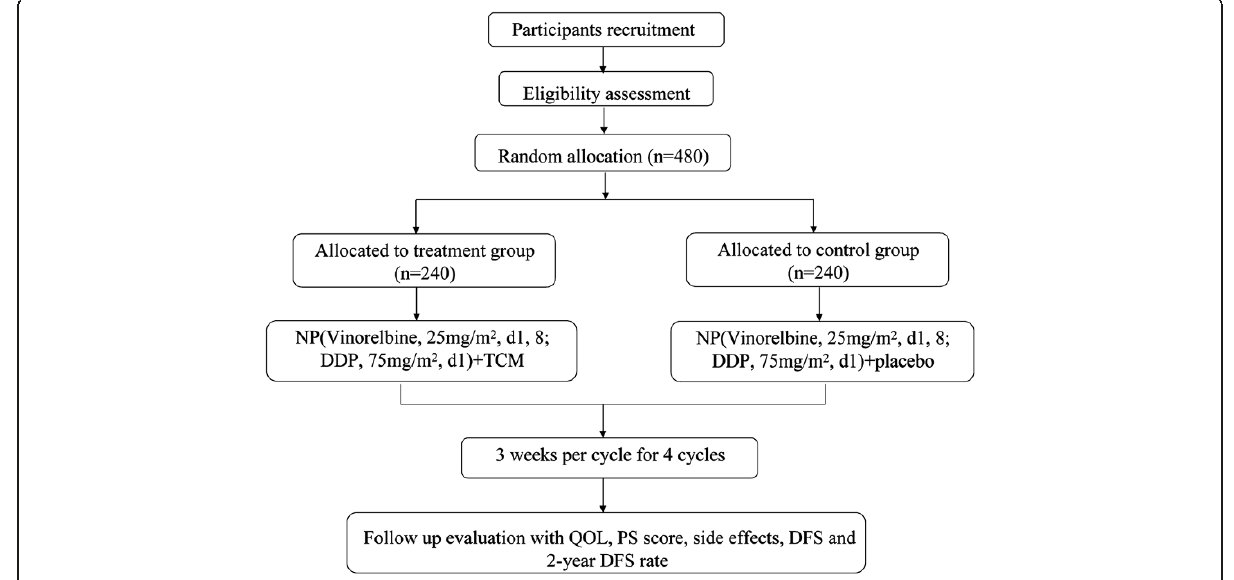
Figure 1 Flow diagram of the